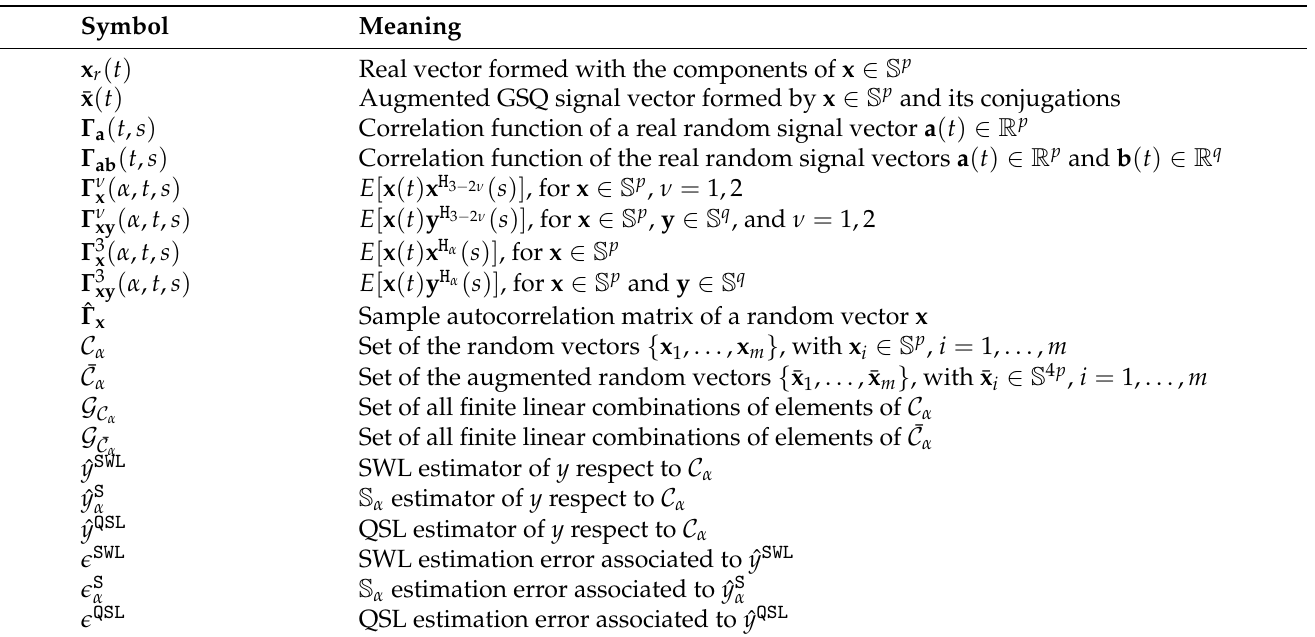
Table 1. List of